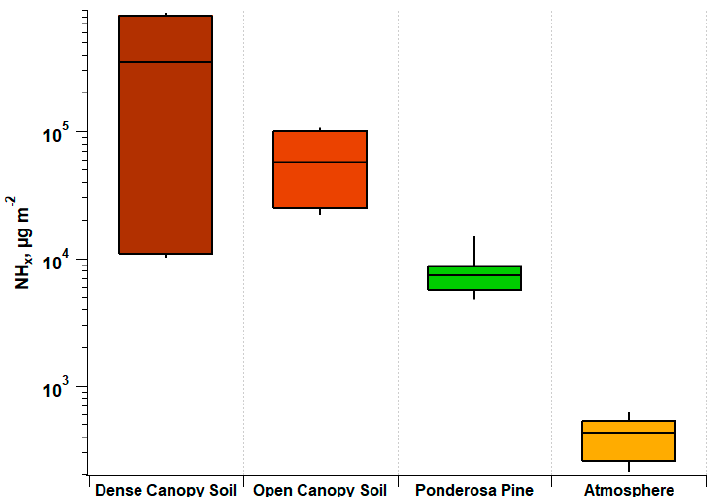
Figure 7. Comparison of measured NH x pools on a logarithmic scale in two distinct soil sampling areas (dense and open canopy soils), the Ponderosa pine (assuming specific leaf area = 43.8 cm 2 g − 1 , [42]) and LAI = 3 [33], and the atmosphere (assuming 1000 m boundary layer depth). Whiskers represent 10 and 90 quartiles, with the box within the 25 to 75 quartiles and the mean marked with a solid line.